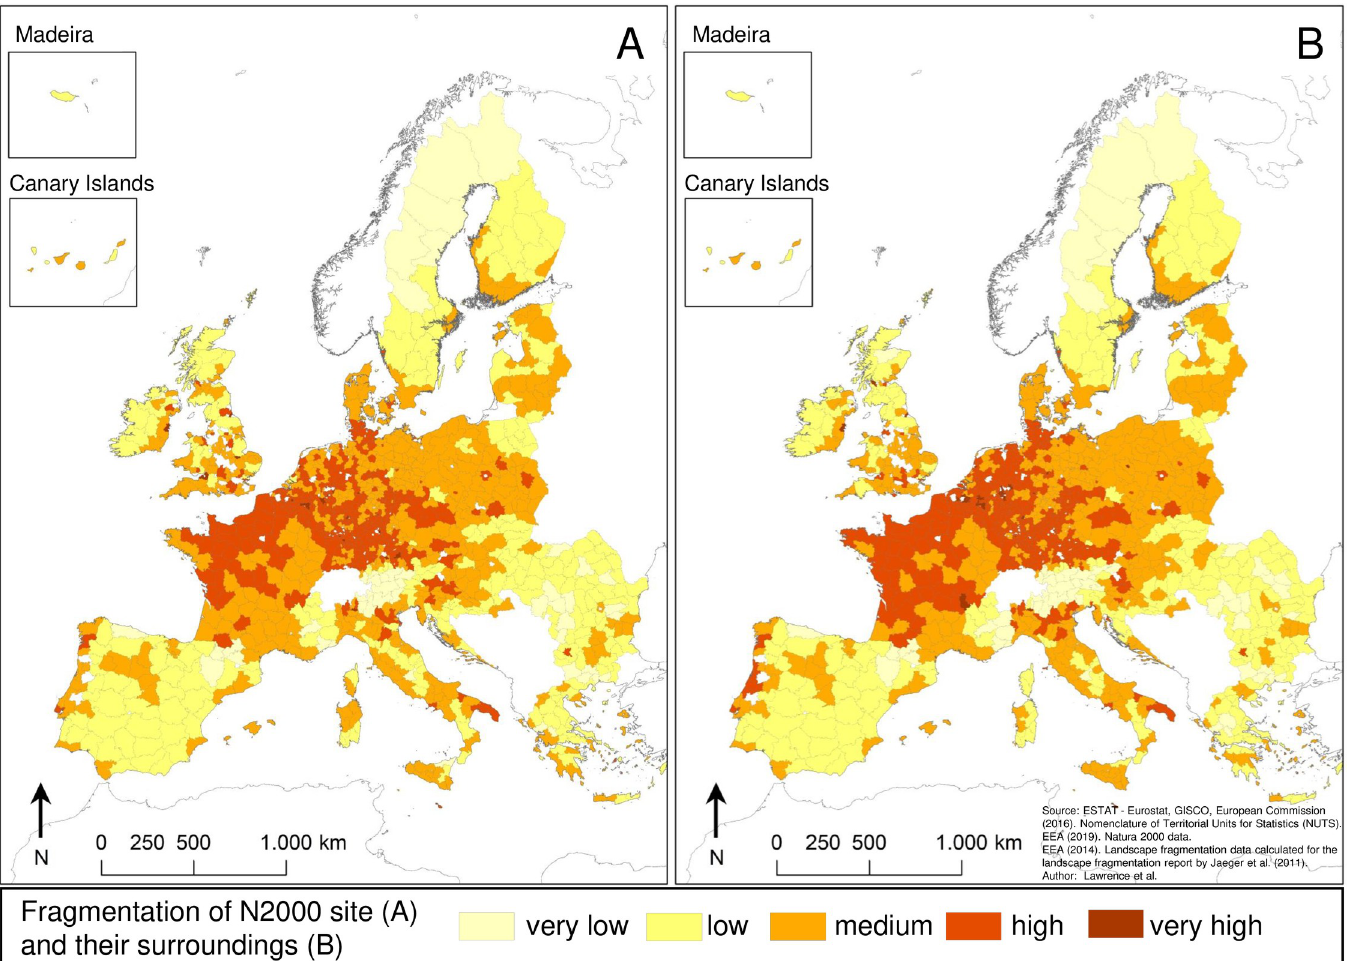
Fig 3. Fragmentation within N2k sites ( seff ) (A) and in their surroundings ( seff ) (B) for NUTS-3 regions. The value for each NUTS-3 region was obtained by within surrounding calculating the median of seff within (A) and the median of seff surrounding (B) of N2k sites for each NUTS-3 region. The area-wide coloration on the map reflects only the degree of fragmentation within (A) or in the surroundings of (B) N2k sites rather than the area-wide fragmentation throughout the NUTS-3 regions. Map generated